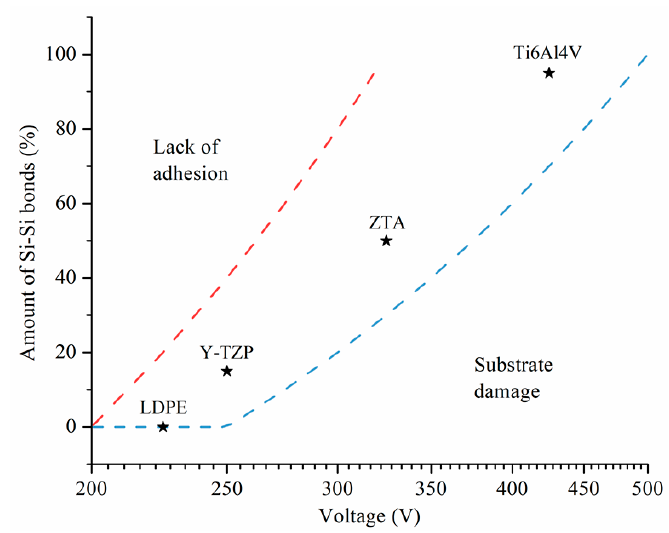
Figure 6. Qualitative representation of the applied voltage / Si-Si bond relationship as measured by X-ray Photoelectron Spectroscopy, as an indicator of substrate chemical composition.